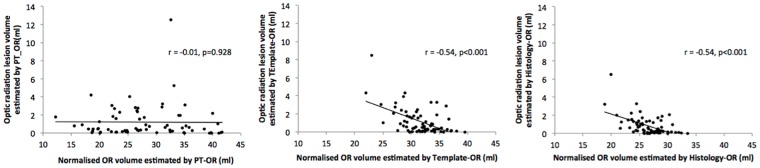
Correlations between OR volumes and OR lesion volumes.